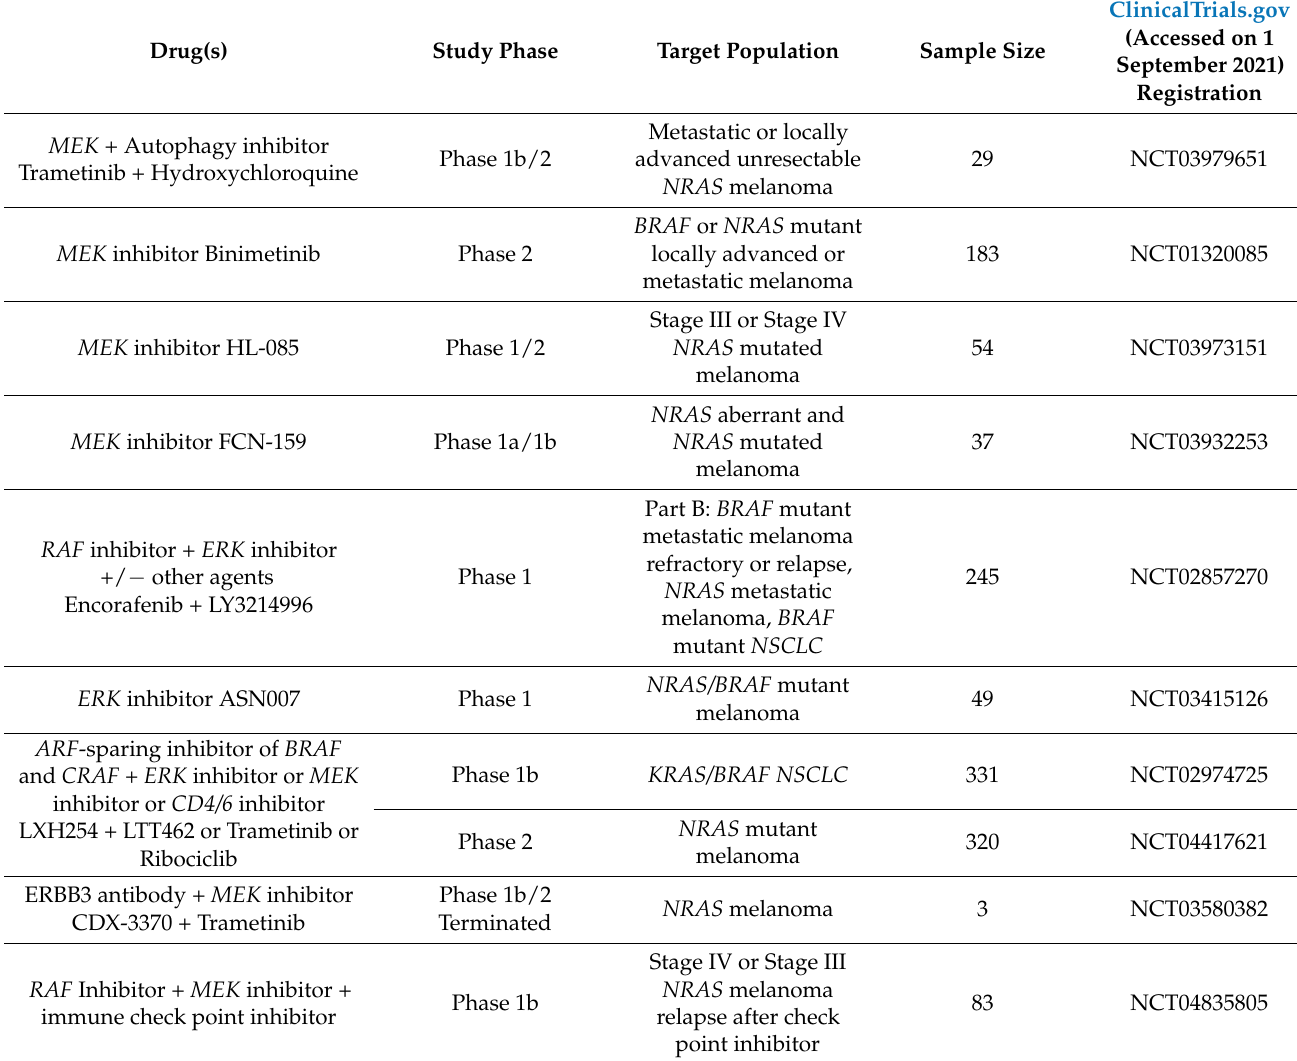
Table 2. Summary of ongoing targeted therapy trials in NRAS mutant